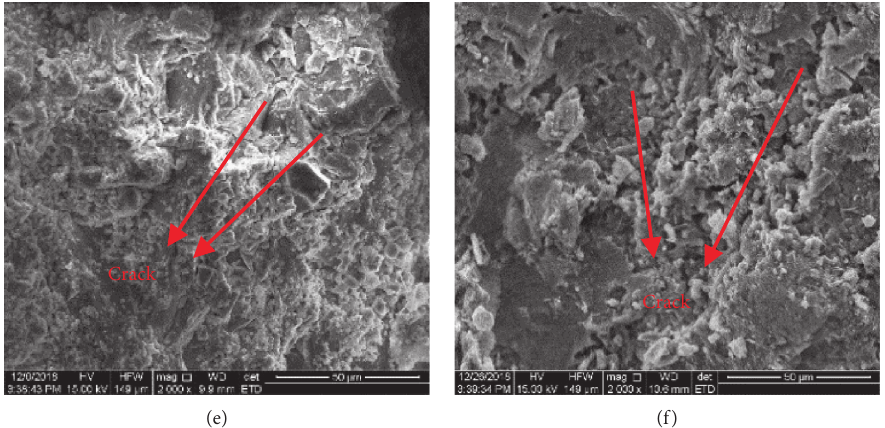
Figure 11: SEM photographs of the concrete under different salt-freezing cycles. (a) D0C0, (b) D28C2, (c) D28C6, (d) D28C8, (e) D28C10, and (f) D8C13.